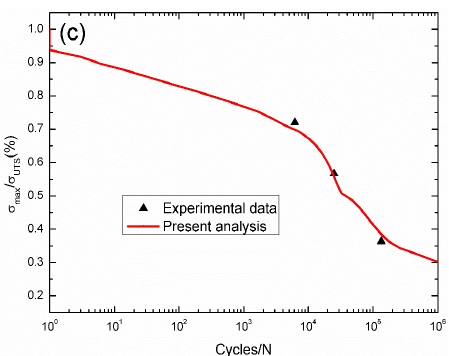
Figure 11. ( a ) The interface shear stress versus applied cycles; ( b ) the broken fiber fraction versus applied cycles; and ( c ) the fatigue life S–N curves of experimental data and theoretical analysis for 2D woven C/SiC composite at 550 °C in air.